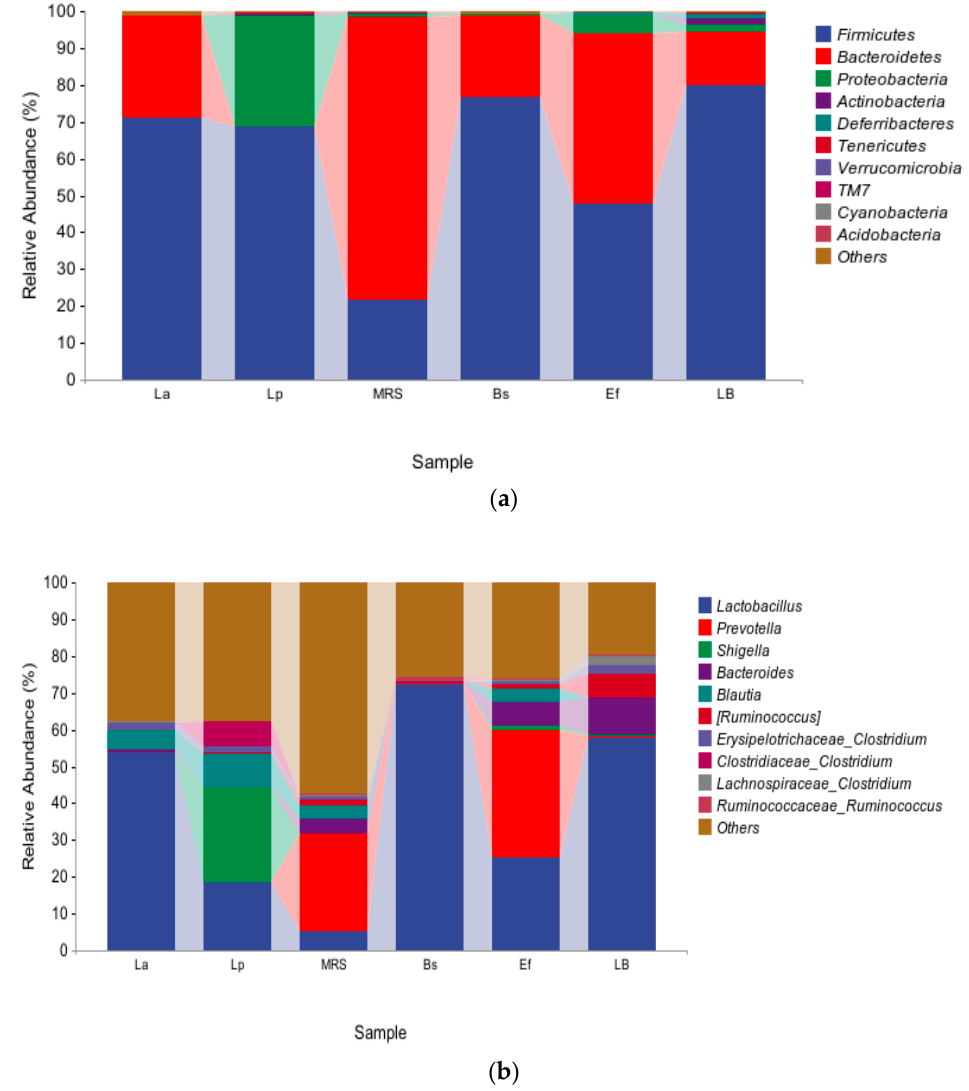
Figure 3. Distribution of gut microbiota: ( a ) species composition at the phylum level; ( b ) species composition at the genus level.